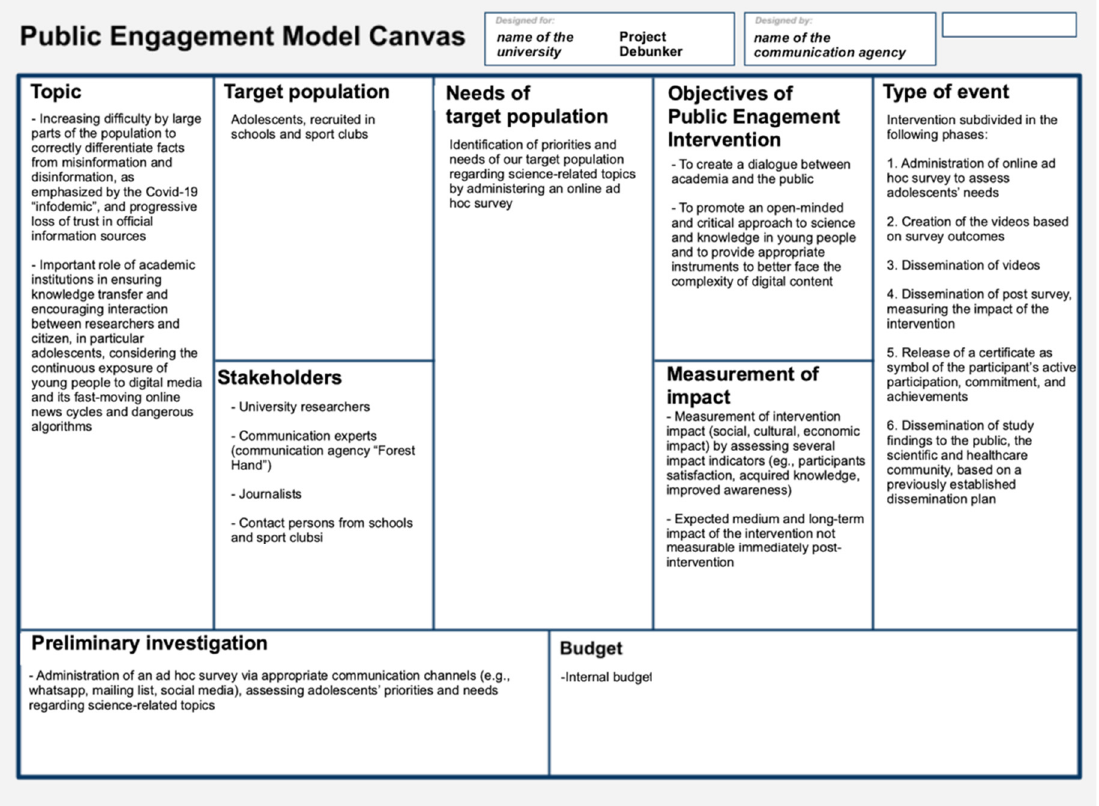
Figure 6. Public Engagement Model Canvas adapted to Debunker.